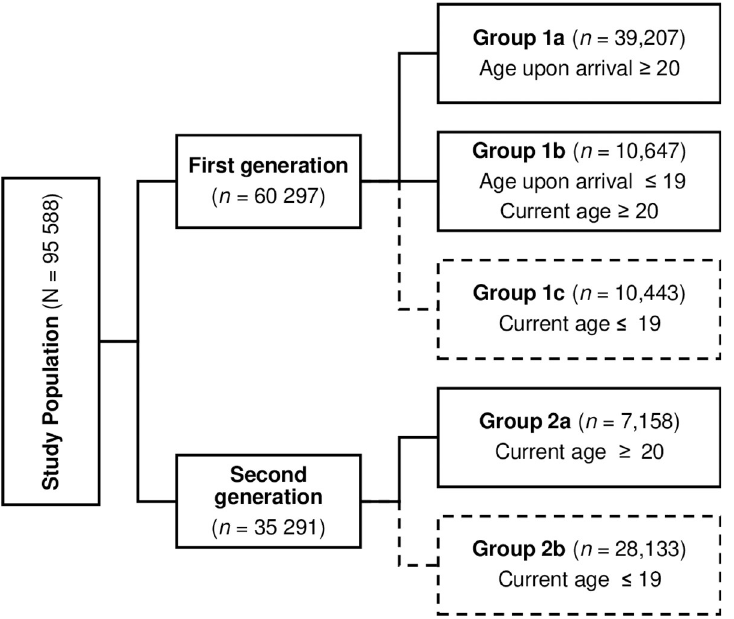
Fig 1. Distinction within female migrants in the Netherlands. Groups that only contribute to the prevalence of FGM/C at January 1st, 2018 (solid boxes) and groups that contribute both to the prevalence of FGM/C and to potential new cases thereafter (dashed